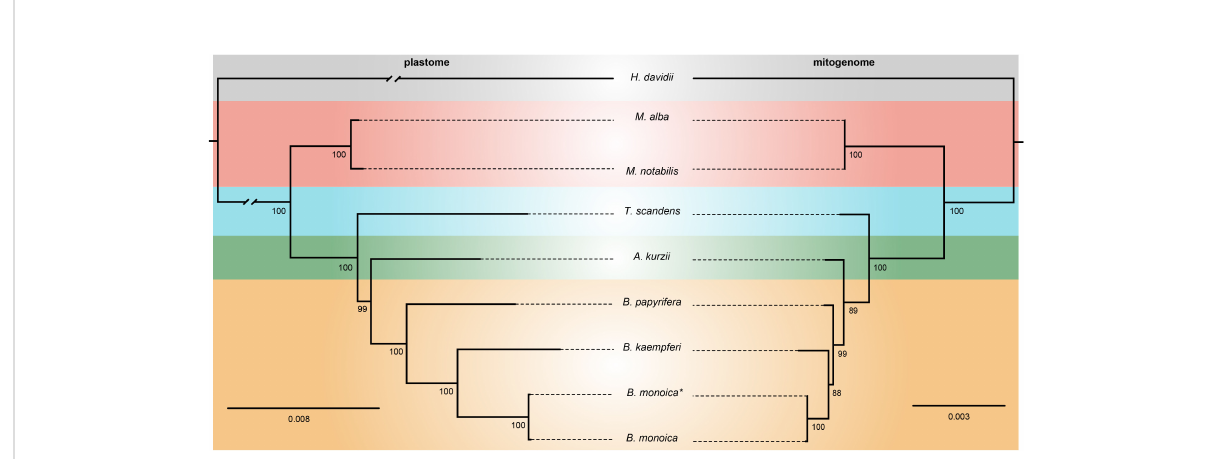
FIGURE 5 ML tree based on 73 shared plastid genes (left) and 13 shared mitochondrial genes (right). The numbers near nodes indicated the bootstrap value. B monoica * was newly sequenced in this study while B monoica was previously sequenced.